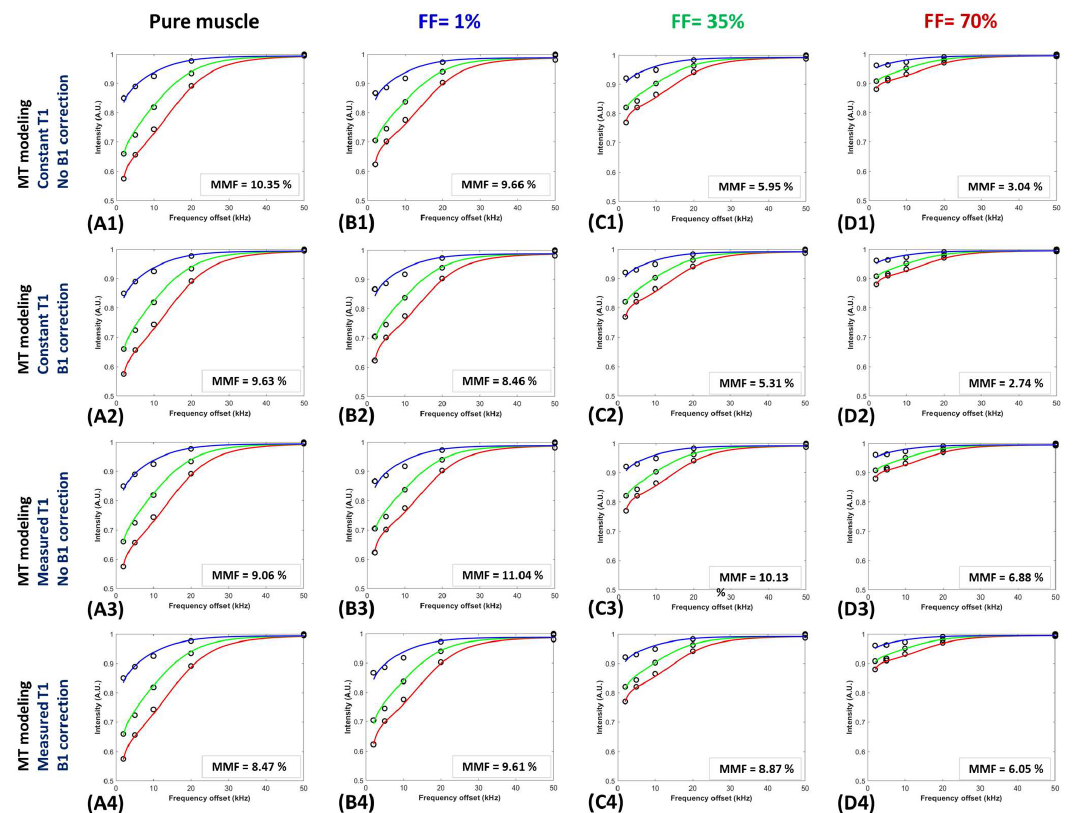
Figure 3. Two-pool UTE-MT modeling using a super-Lorentzian function over variable off-resonance frequencies for three different power levels (500°, 1000°, and 1500° power levels are shown in blue, green, and red lines) within four exemplary ROIs with ( A1 – A4 ) FF= 0 (pure muscle far from fat border, Figure 1A), ( B1 – B4 ) FF = 1% (Figure 2A), ( C1 – C4 ) 35% (Figure 2A), and ( D1 – D4 ) FF = 70% (Figure 2A). MT modeling was repeated using (1) a constant T1 (T1 = 750 ms, i.e., average T1 values measured in pure muscle regions) and no B1 correction (i.e., B1 = 1), (2) a constant T1 and B1 correction (from the AFI sequence), (3) a measured T1 (from the AFI-VFA sequence) and no B1 correction, and (4) a measured T1 and B1